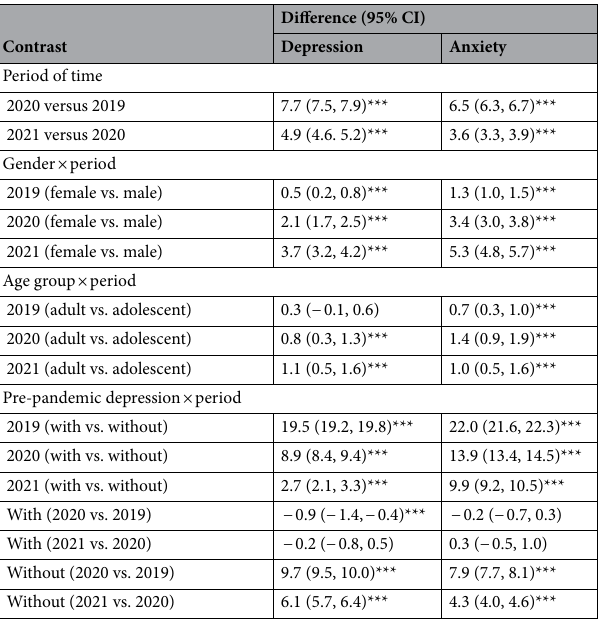
Table 3. Post-hoc calculated contrasts within the linear mixed model (N = 11,523) for depression and anxiety scores with pandemic period, gender, age group and pre-pandemic depression/anxiety status as fixed effects and individual-specific random effects nested within the time variable, adjusted for job-related status and subjective social status. p values are Bonferroni-corrected. * p < .05, ** p < .01, *** p < .001.